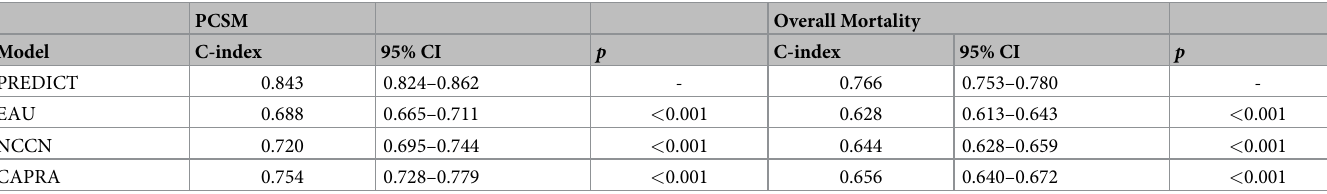
Table 4. Discrimination of the model, compared with other existing models amongst the UK validation cohort over 15 years maximum follow-up ( n = 3,026). PCSM